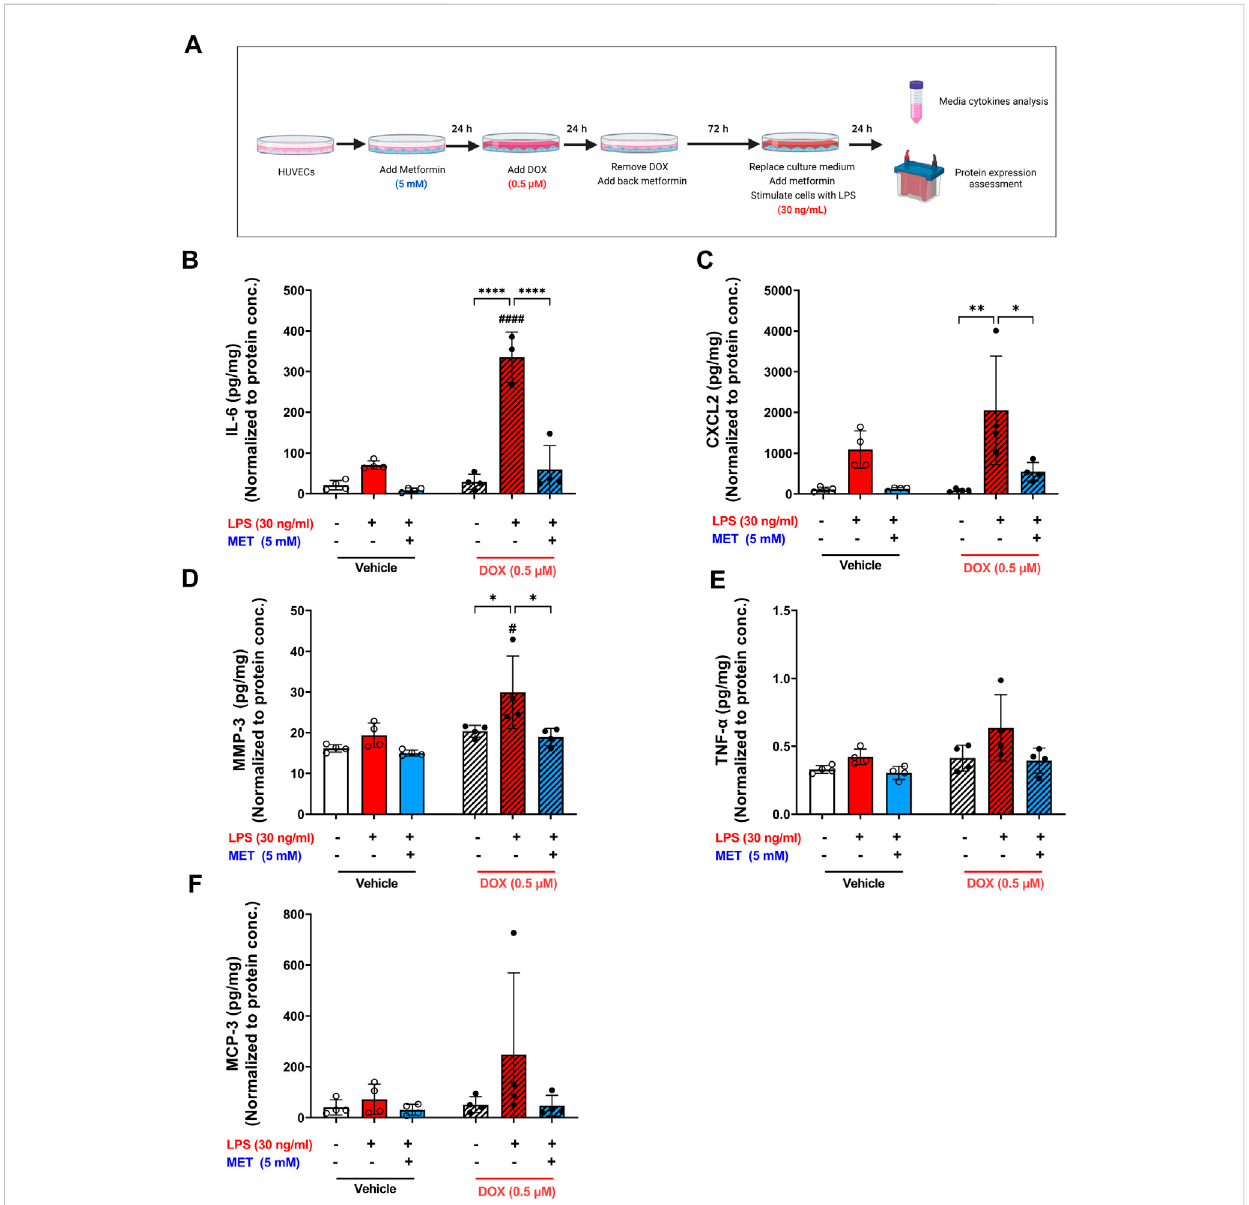
FIGURE 5 Metformin ameliorated LPS-triggered hyper-in fl ammation in DOX-induced senescent HUVECs. (A) Schematic diagram of the experimental design. HUVECs were treated for 24 h with 0.5 µM DOX ±5 mM metformin (added 24 h before DOX) or left untreated. Thereafter, DOX was removed and the cells were incubated in DOX-free media with or without metformin for an additional 72 h. The media were changed so that the assessed SASP factors in the media re fl ect only the effect of LPS. Then, cells were stimulated with LPS (30 ng/mL)for an additional 24 h. Thereafter, conditioned media were collectedandtheproteinexpressionofSASPfactorsincluding (B) IL-6, (C) CXCL2, (D) MMP-3, (E) TNF- α ,and (F) MCP-3wasdeterminedbyLuminex(n= 4). Values were normalized to the protein concentration of the cells determined by BCA. Expressed values are presented as mean ± SEM. Data were analyzed by two-way ANOVA followed by a Tukey multiple comparisons test. * compared to different treatment within the same group; * p < 0.05, ** p < 0.01, **** p < 0.0001. # compared to non-senescent cells with the same treatment; # p < 0.05, #### p <